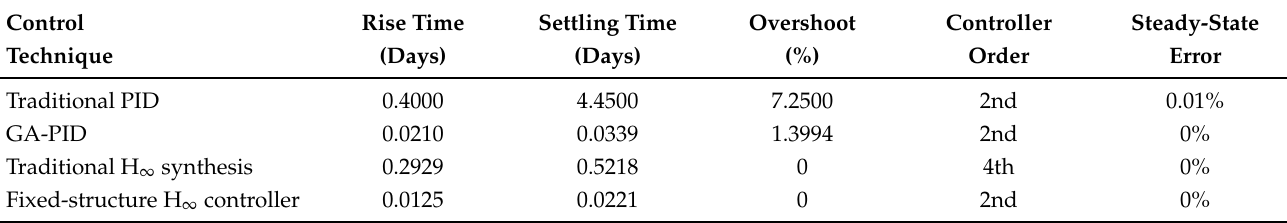
Table 5. Comparison of performance for the